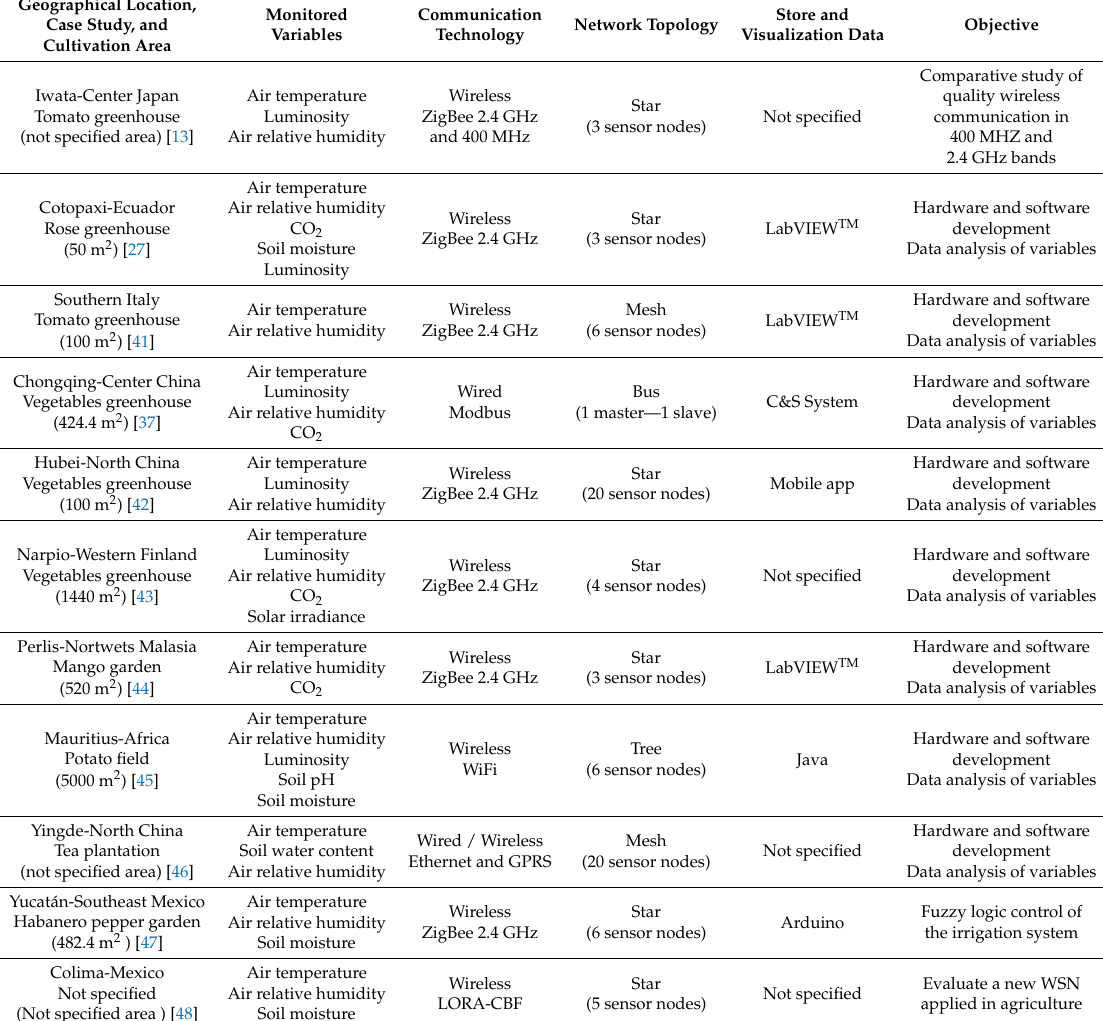
Table 1. Summary of related work for WSNs in